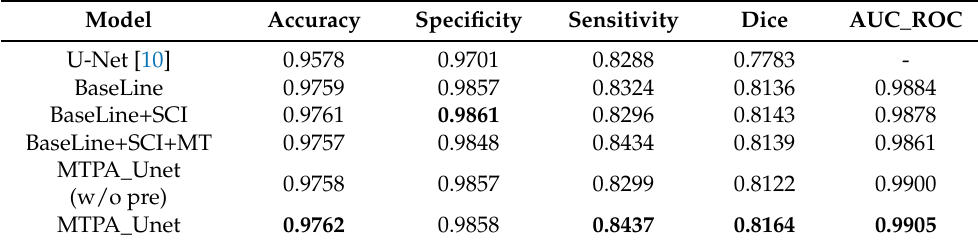
Table 2. Ablation experiments on the CHASE DB1